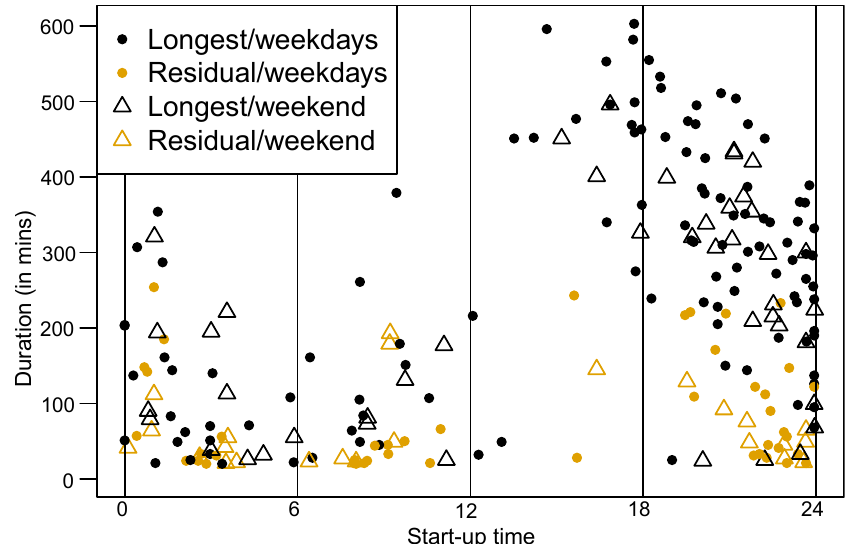
Figure 4. Each point represents a charging block of a specific EV detected during one year. Minute of the start-up time is on the x -axis, and duration of the block on the y -axis. Filled circles, or empty triangles, indicate that the charging occurred during a weekday, or a weekend day, respectively. Colors indicate if this is the longest/main block of the day or a residual